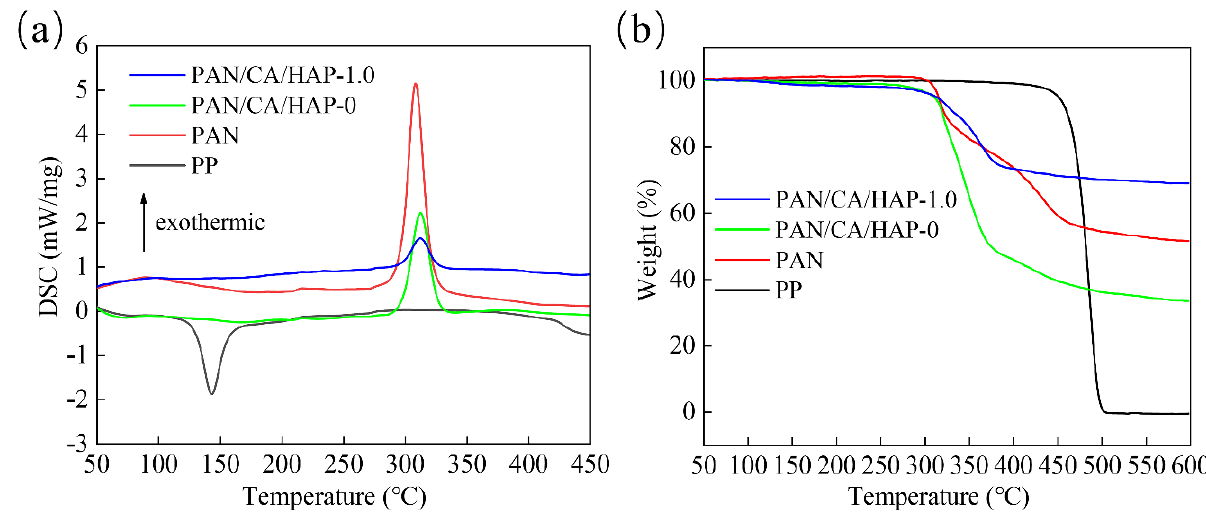
Figure 6. ( a ) DSC and ( b ) TG curves of PP, PAN, PAN/CA/HAP-0 and PAN/CA/HAP-1.0 separators.